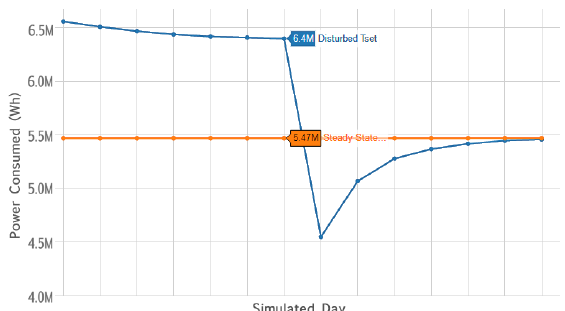
Figure 2. In the blue, an extreme schedule of t set, d , h = 60°F for every timestep in the planning horizon (all d ∈ D and s ∈ S ). The default policy is to operate at 75°F for all occupied hours, which has its steady state power draw in orange.